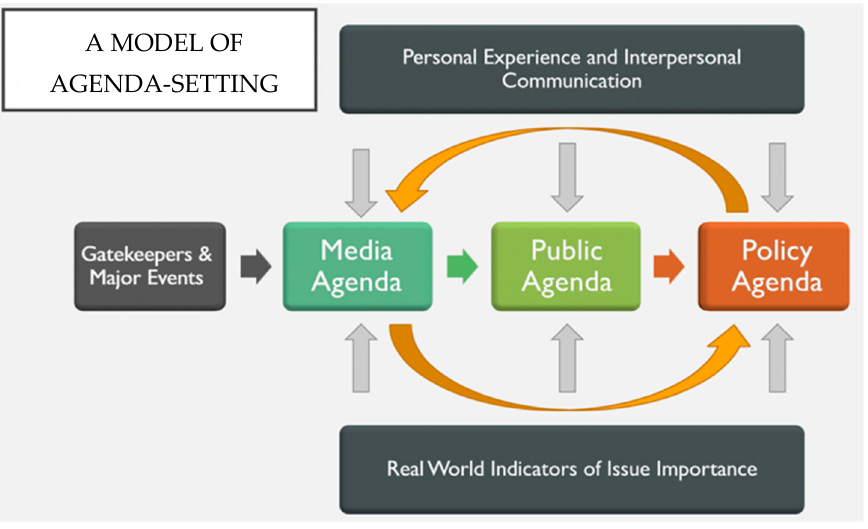
Figure 5. Model of agenda-setting (Mores and Georgacopoulos 2020).